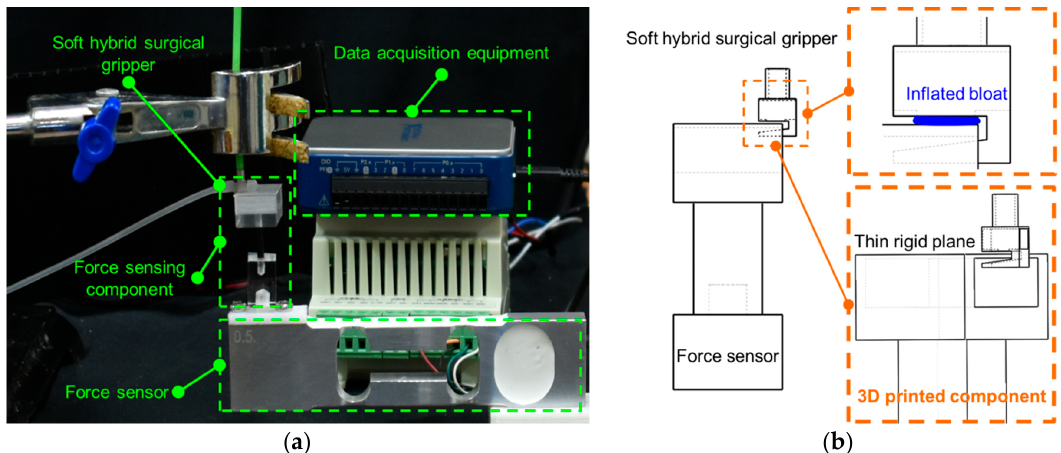
Figure 7. The schematic diagram of the contact force sensing experiments: ( a ) the experimental setup for measuring the force generated by the inflation of the soft pneumatic channel; ( b ) the zoom-in figure of the sensing part between the inflated bloat and the thin rigid plane.